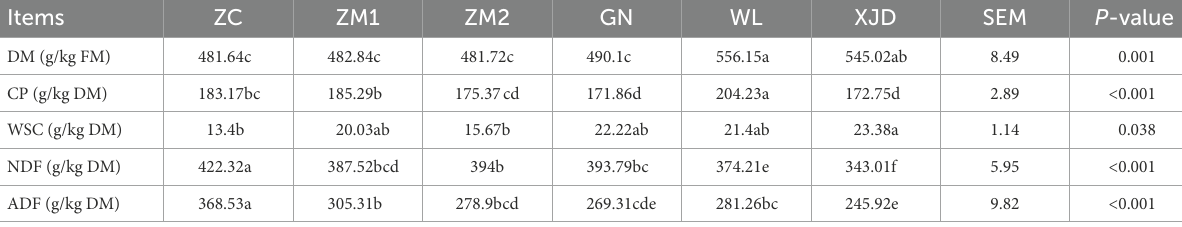
TABLE 2 Chemical composition of alfalfa silage after 60 days of ensiling. Items